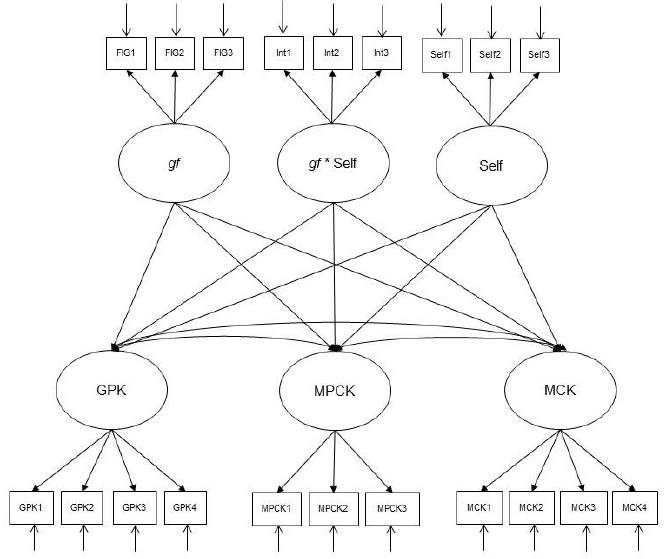
Figure 4. The moderation model (H6). Note. MCK = mathematics content knowledge; MPCK = mathematics pedagogical content knowledge; GPK = general pedagogical knowledge; gf = fluid intelligence; Self = self-concept in mathematics; * = interaction.